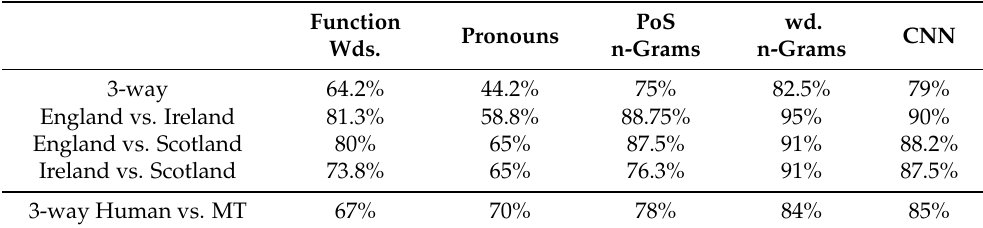
Table 5. The percentage of documents from the test set classified with the same label in both English and French translated versions. The last row compares the 3-way classification similarities between dialectal classification of documents from human and machine translated output. Function